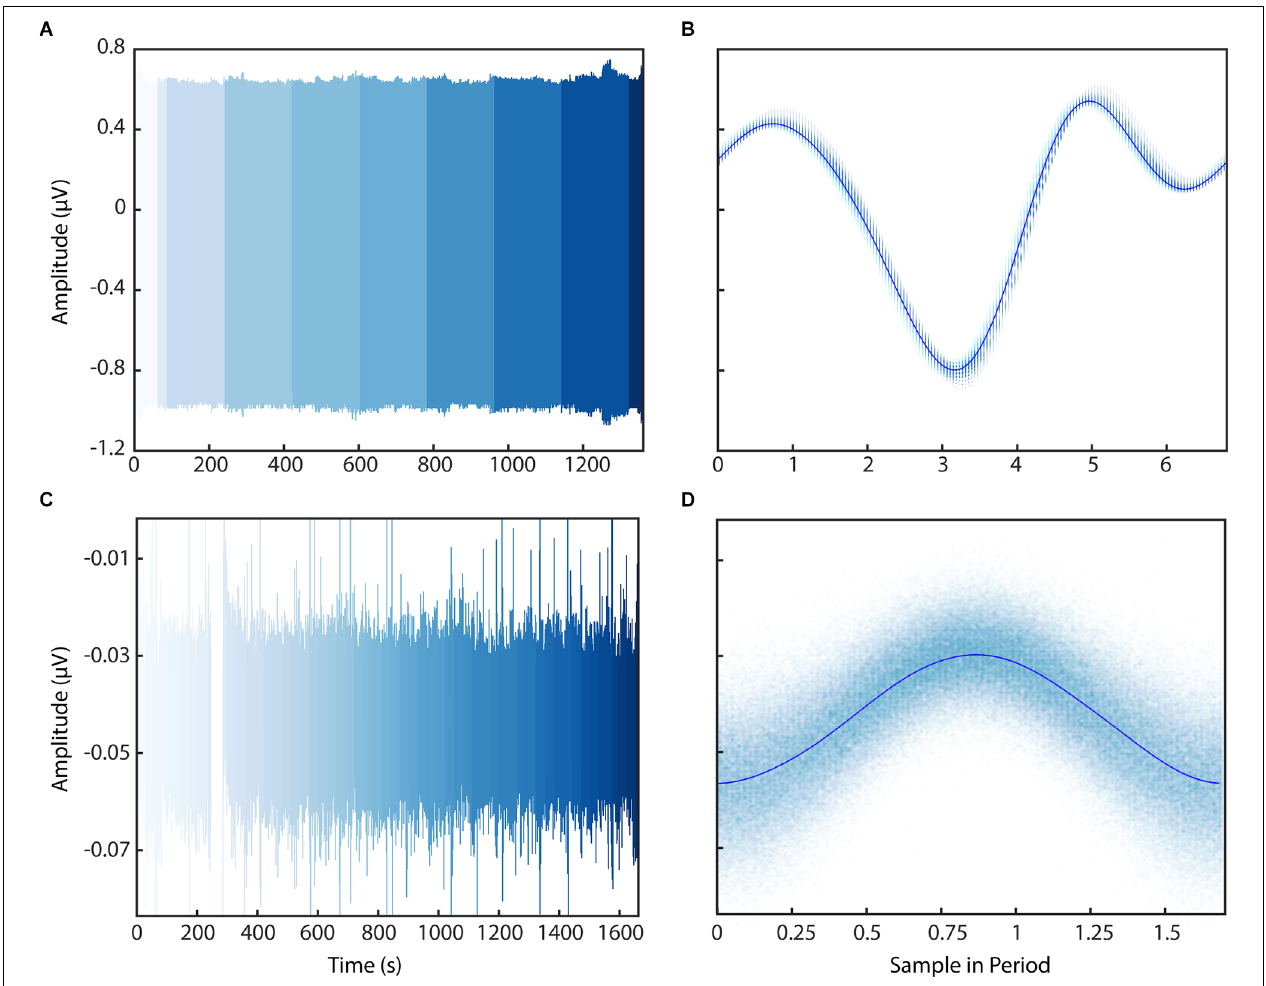
FIGURE 6 | Application of PELP to data from the Medtronic Summit RC + S. PELP was applied to RC + S data containing losses sampled at 1,000 Hz (A,B) and 250 Hz (C,D) . Each continuous run is indicated by a distinct shade in the colormap (A–C) . For both conditions, samples from all runs were overlapped on the timescale of the period of stimulation (B–D) . Samples were well consolidated in the stimulation model for both conditions indicating accurate estimation of loss